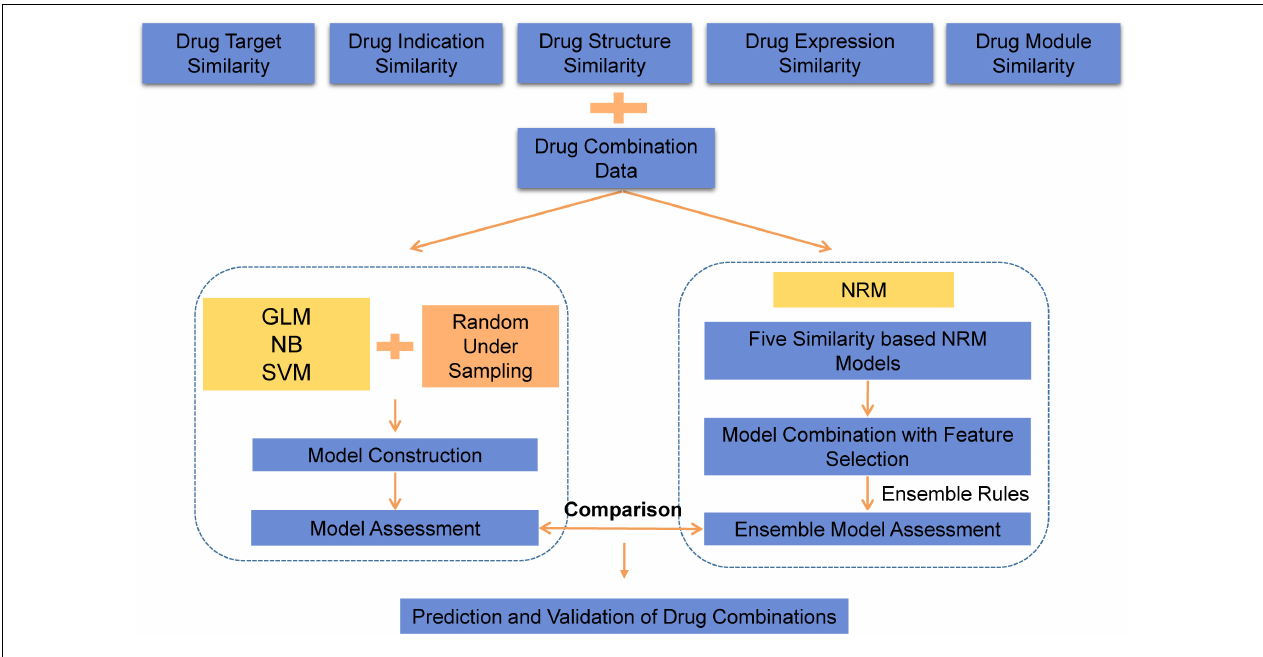
FIGURE 1 | The workflow of drug combination